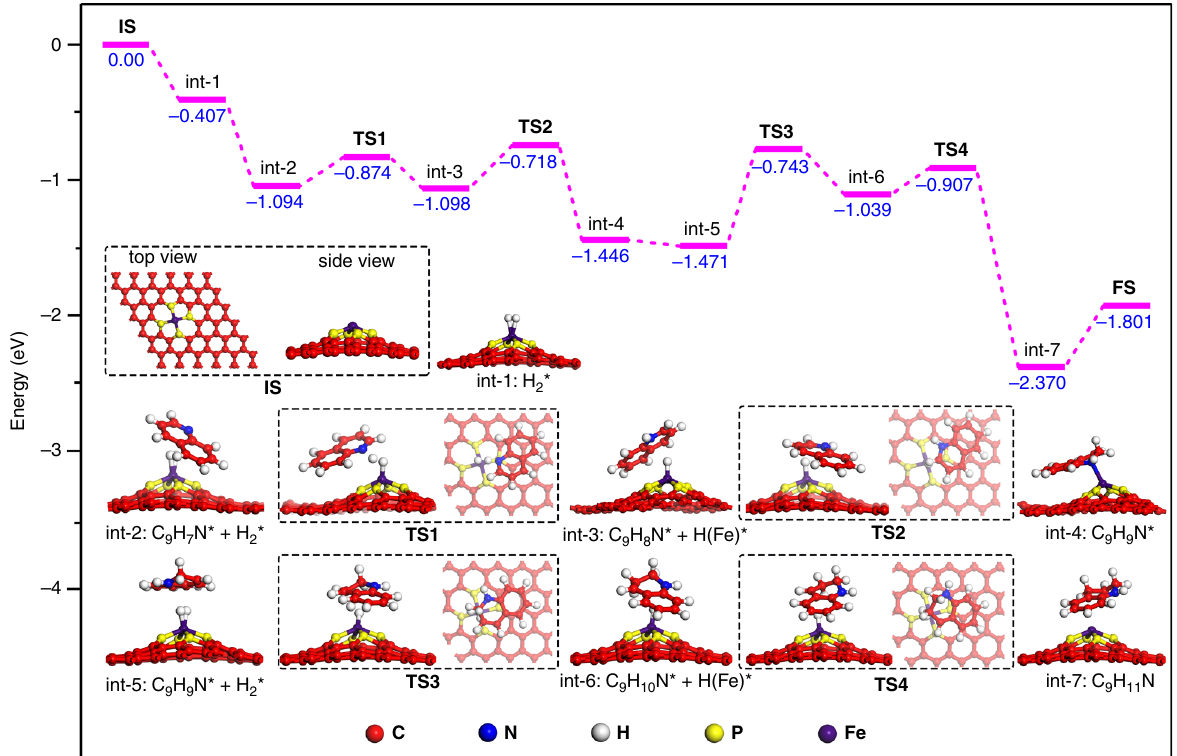
Fig. 4 Catalytic mechanism study of Fe-P 900 -PCC for hydrogenation of quinoline. Energies of intermediates (int) and transition states (TS) in the mechanism of quinoline stepwise hydrogenation on the O 2 -Fe-P 4 from DFT calculations. IS initial state, FS fi nal reaction continues to give the fi nal product via the addition of second hydrogen molecule, and the reaction of C 9 H 9 N * to C 9 H 10 N * (int-5 to int-6) is found to be the rate-determining step with an energy barrier of 0.728 eV.